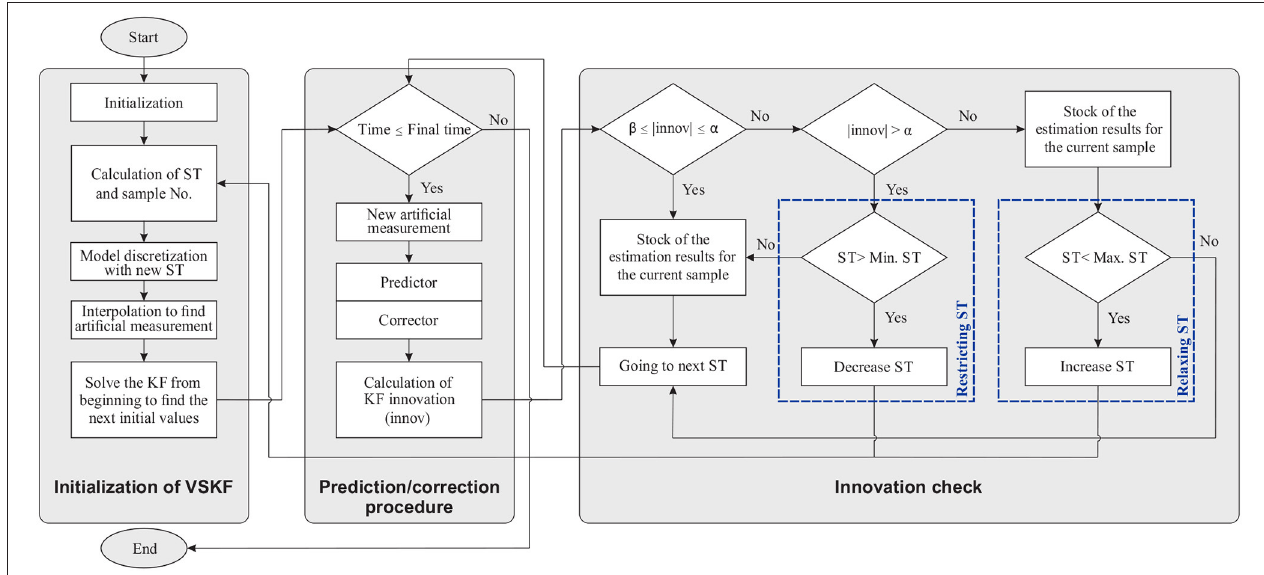
FIGURE 1 | Event handling procedure of variable step size Kalman Filter.